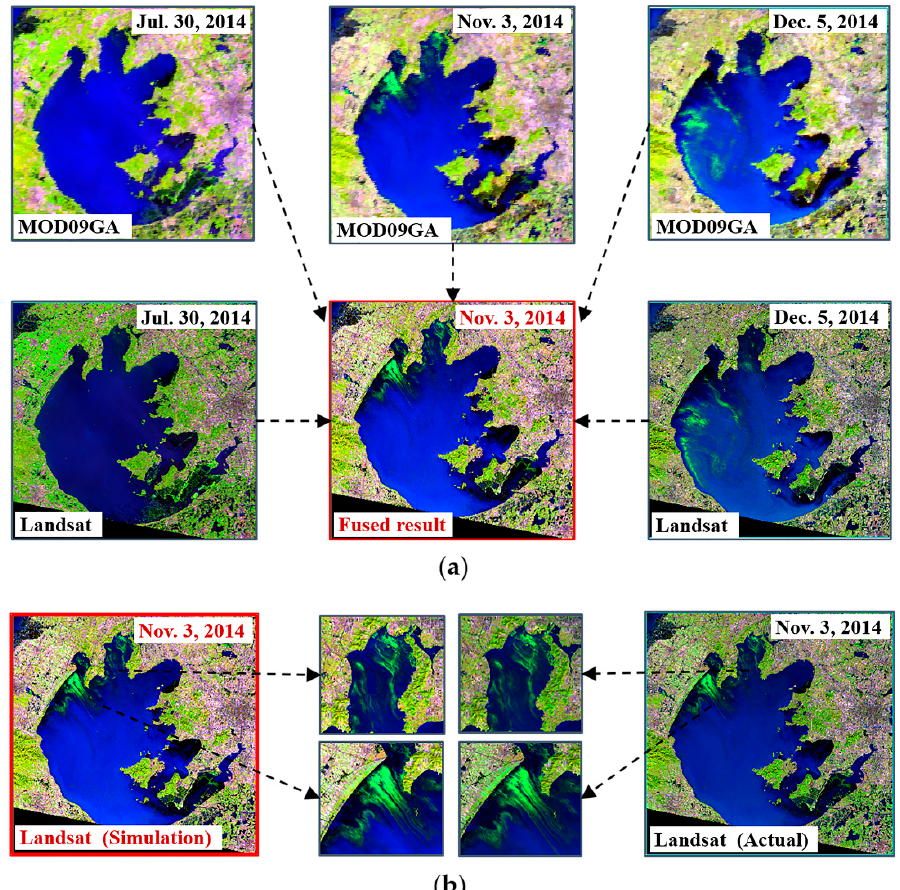
Figure 4. Simulated validation of the STF method (the order of the band: short-wave infrared, near-infrared, red). ( a ) Schematic diagram of the fusion of high-resolution images of Taihu Lake. ( b ) Comparison and validation between the simulated Landsat-like image obtained using the STF method and the actual Landsat image.